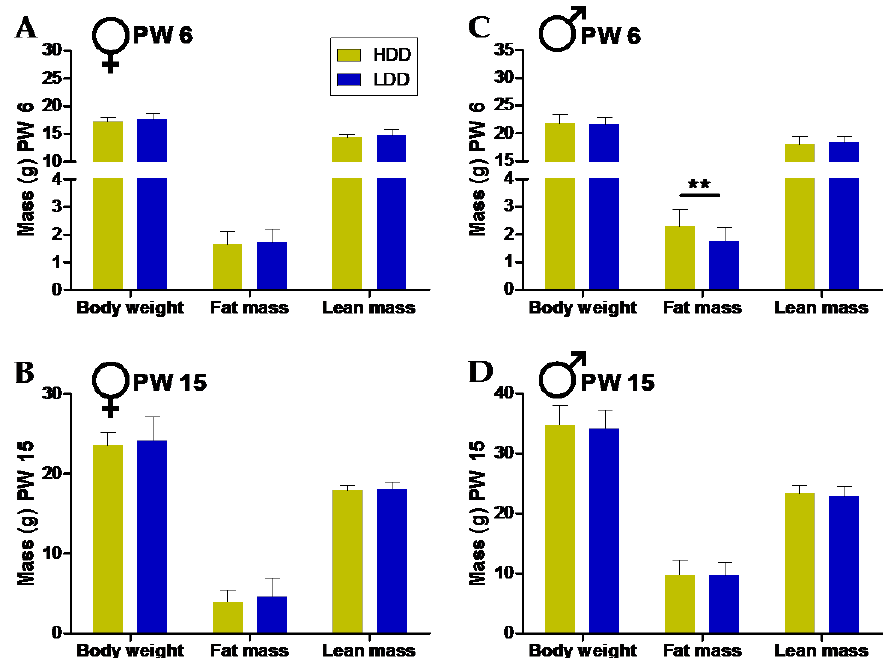
Figure 2. Direct and long-term effects of the type of starch consumed in the early post-weaning period on body weight (BW) and body composition. BW, fat mass (FM), and lean mass (LM) of females directly after exposure to HDD or LDD ( A ; PW 6, n = 24 per group), and after nine weeks on a HFD ( B ; PW 15, n = 12 per group). The BW, FM, and LM of males after exposure to HDD or LDD ( C ; PW 6, n = 24 for HDD and n = 23 for LDD), and after nine weeks on a HFD ( D ; PW 15, n = 12 per group). Note truncated x-axis in panels A and C to enhance visualization. Data shown as mean ± standard deviation (s.d.). Statistical differences denoted as ** p ≤ 0.01.